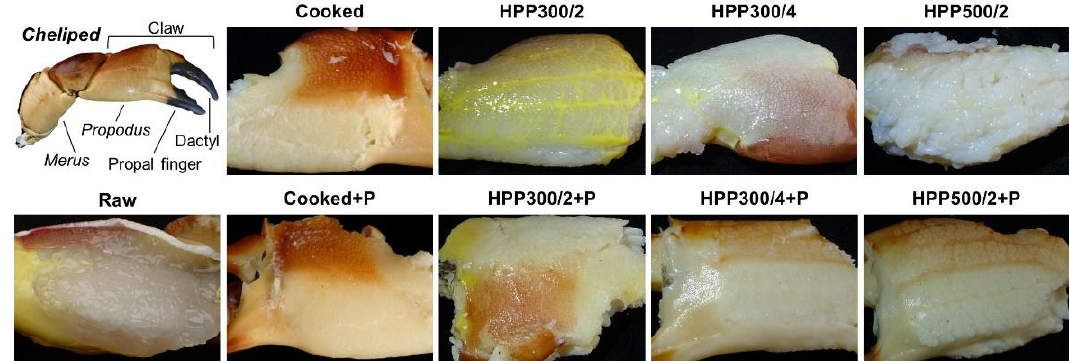
Figure 4. Illustration of the anatomy of a cheliped of edible crab ( Cancer pagurus ) and images of meat of the propodus of raw (i.e., untreated), cooked, and high-pressure processed claws, before and after thermal pasteurization (indicated with +P).